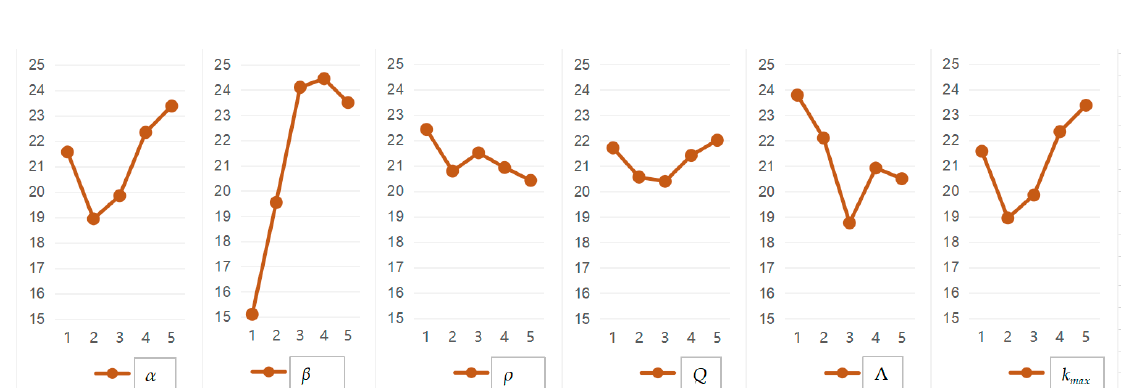
Figure A2. The main effect graph of ACO.